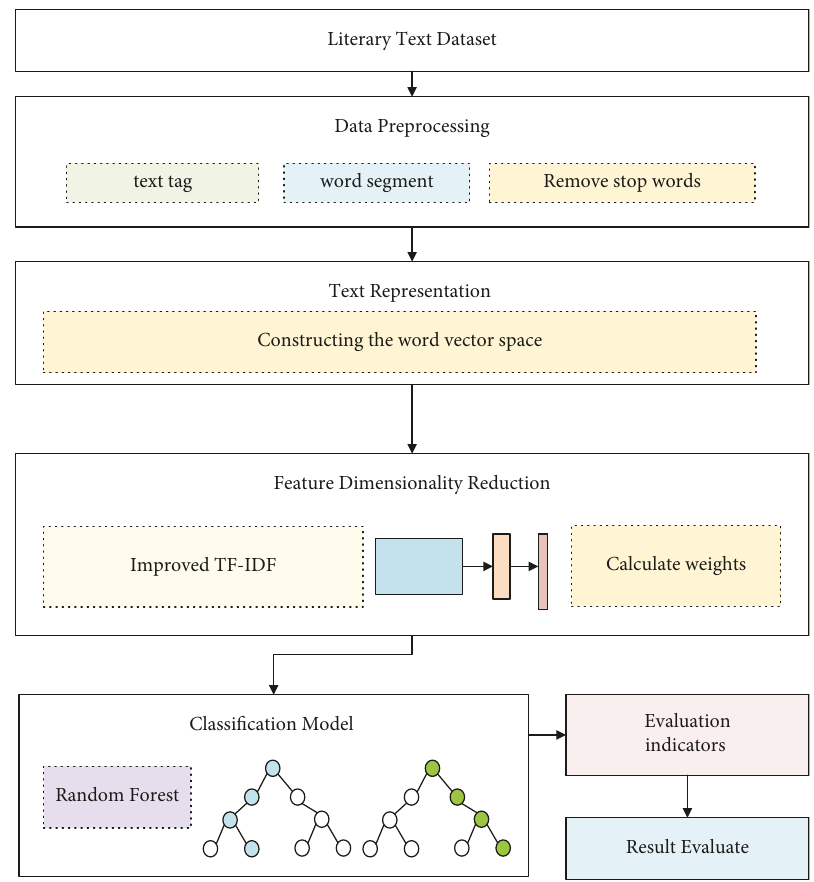
Figure 2: Literature text classification process based on improved TF-IDF method. Table 1: Classification performance evaluation